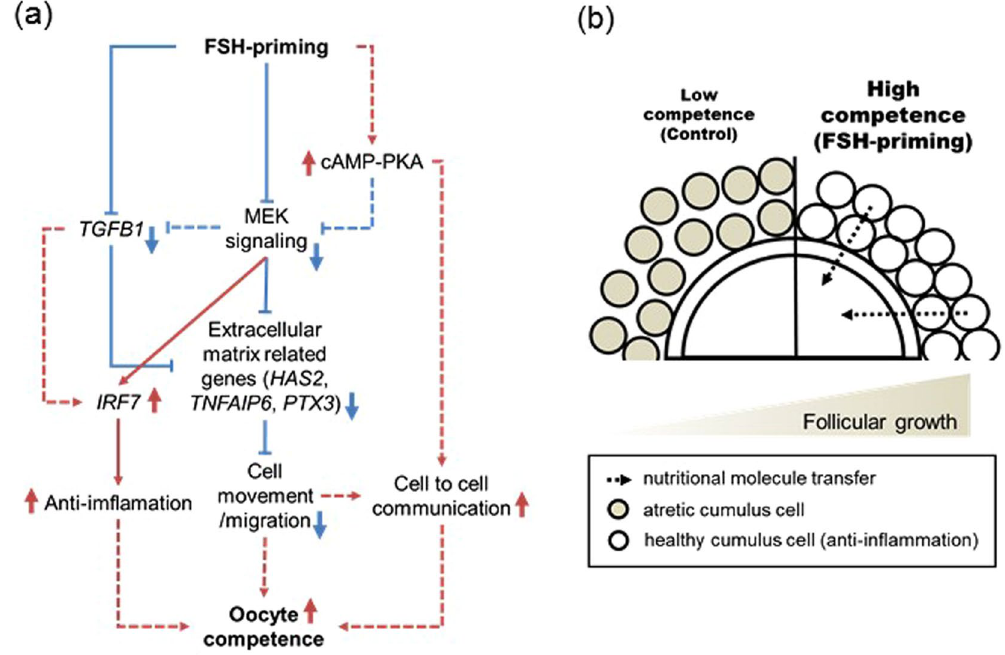
Figure 6. Hypothetical signalling network and status in bovine cumulus cells modified by FSH-priming based on RNA-seq expression signature. FSH-priming stimulates an anti-inflammatory cascade via the activation of IRF7 pathway following TGFB1 pathway inhibition. The inhibited TGFB1 pathway may result from the inhibition of MEK signalling. FSH-priming prevents cell movement/migration via the inhibition of genes involved in extracellular matrix expansion (HAS2, TNFAIP6, and PTX3) following MEK signalling inhibition, which may be related to enhancing cell-to-cell communication. Moreover, FSH PRIMING stimulates cAMP- PKA, which may participate in the inhibition of MEK signalling and activation of cell-to-cell communication such as gap-junctional communication ( a ). Cumulus cells in a low competence model without FSH-priming are in a state of poor cell-to-cell communication, progressing atresia, and driving a spontaneous ovulation- like cascade. Conversely, cumulus cells in a high competence model following FSH-priming are in a state of enhanced cell-to-cell communication and are maintained healthy by the activated anti-inflammatory cascade, which allow the transport of nutritional molecules from cumulus cells to oocytes at the time of final oocyte maturation ( b ). MEK, mitogen-activated protein kinase/extracellular signal-regulated kinase kinase; cAMP- PKA, cyclic adenosine monophosphate-protein kinase A signalling